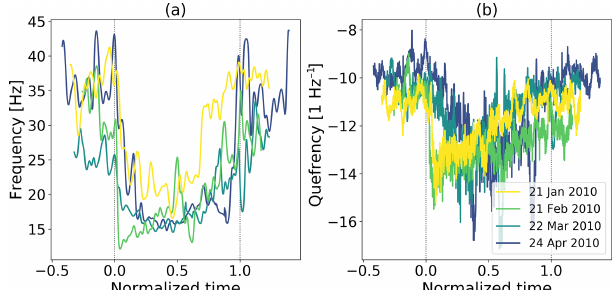
Figure 6. (a) Central frequency with normalized time for four dif- ferent avalanche events (colors) from 4 different months. For com- parison, the time was normalized by the event duration, with 0 indi- cating the start of the avalanche and 1 the end of the event. (b) Sec- ond cepstral